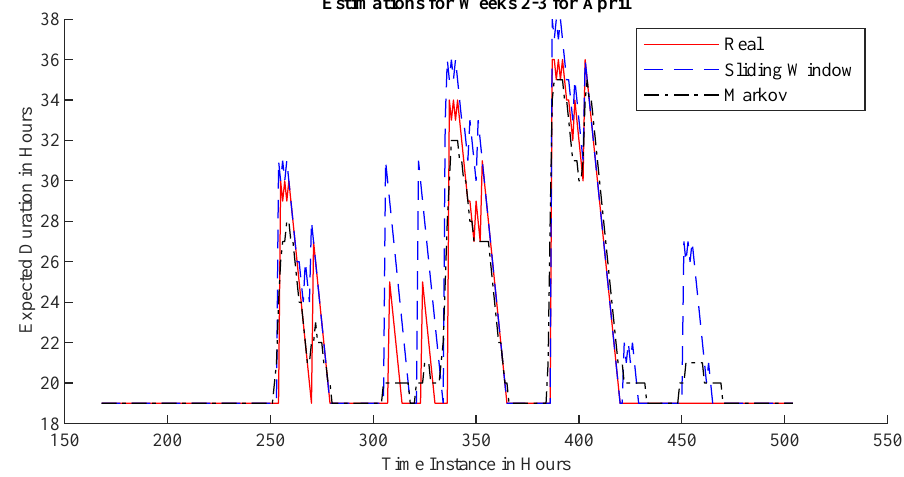
Figure 6. Estimation for the Markov-Chain and Sliding-Window approaches compared to the real